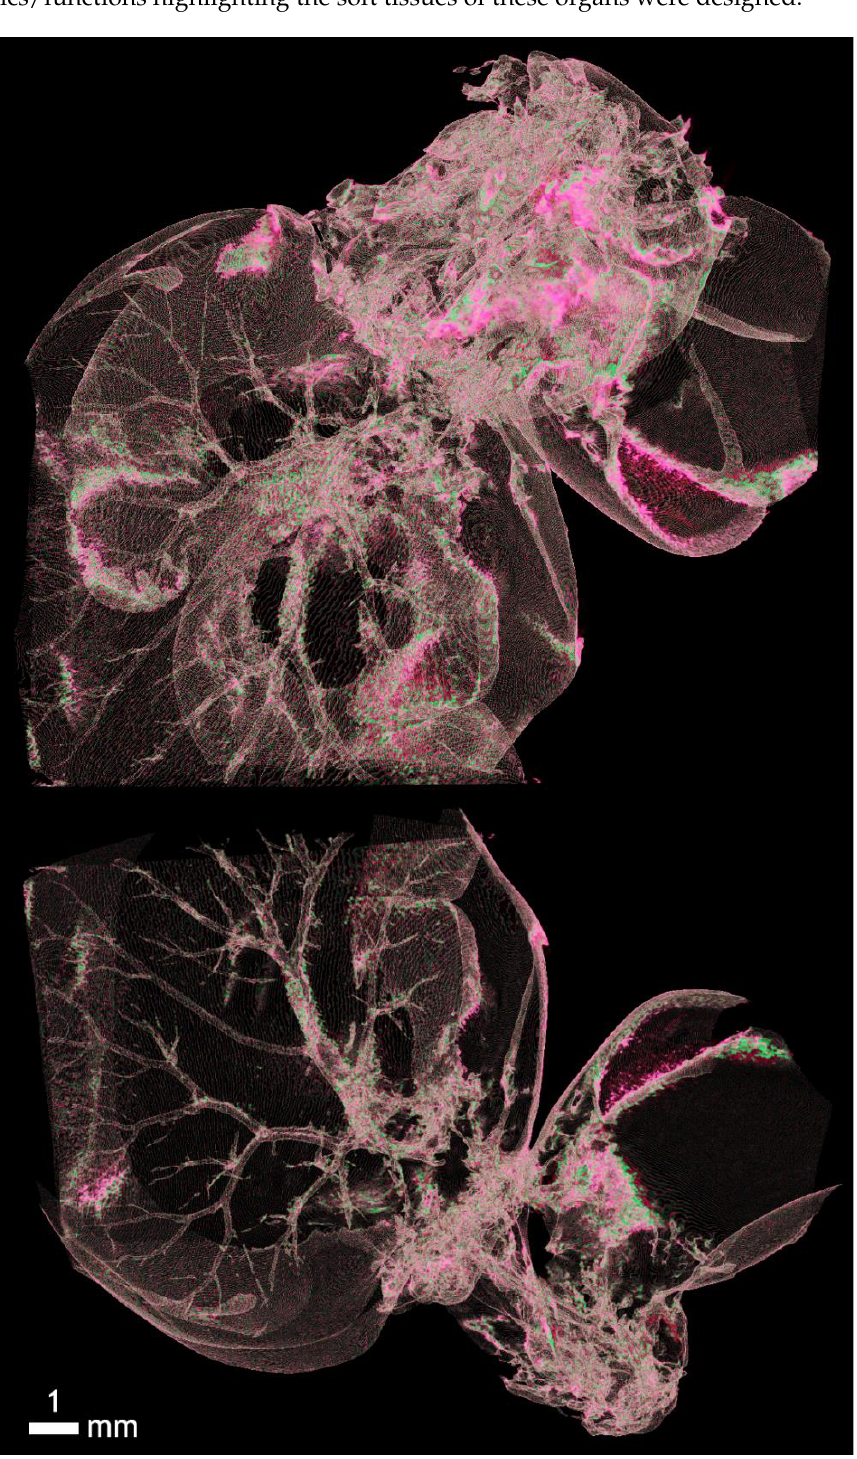
Figure A8. Detailed view of the lobe of the liver and segmental vessels using Omnipaque contrast. Here, is a physiological finding. According to the drawing of the vasculature, we can also describe possible pathological conditions, reconstruction of the liver parenchyma, and its irregular vascular bed or proliferation of blood vessels in tumors.